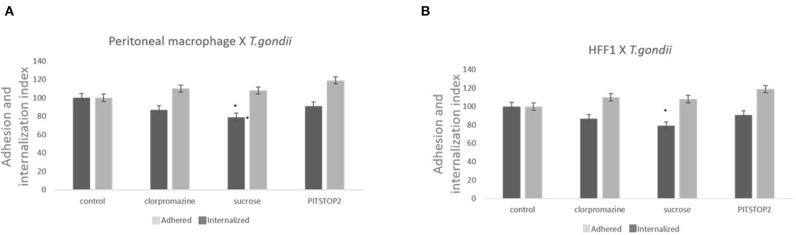
Inhibitors against the clathrin pathway promote the inhibition of T. gondii internalization. Macrophages (A) and HFF1 cells (B) treated with chlorpromazine hydrochloride (10 μg/mL), sucrose hypertonic medium (0.45 M), and pitstop 2 (20 nM), for 60 min, washed with PBS (three times) and then infected with T. gondii (30 min), as described in the Materials and Methods. Note that after all treatments there is a significant reduction of entry into both cell types when compared with control (* indicates significant difference in relation to the control with value of p < 0.05).